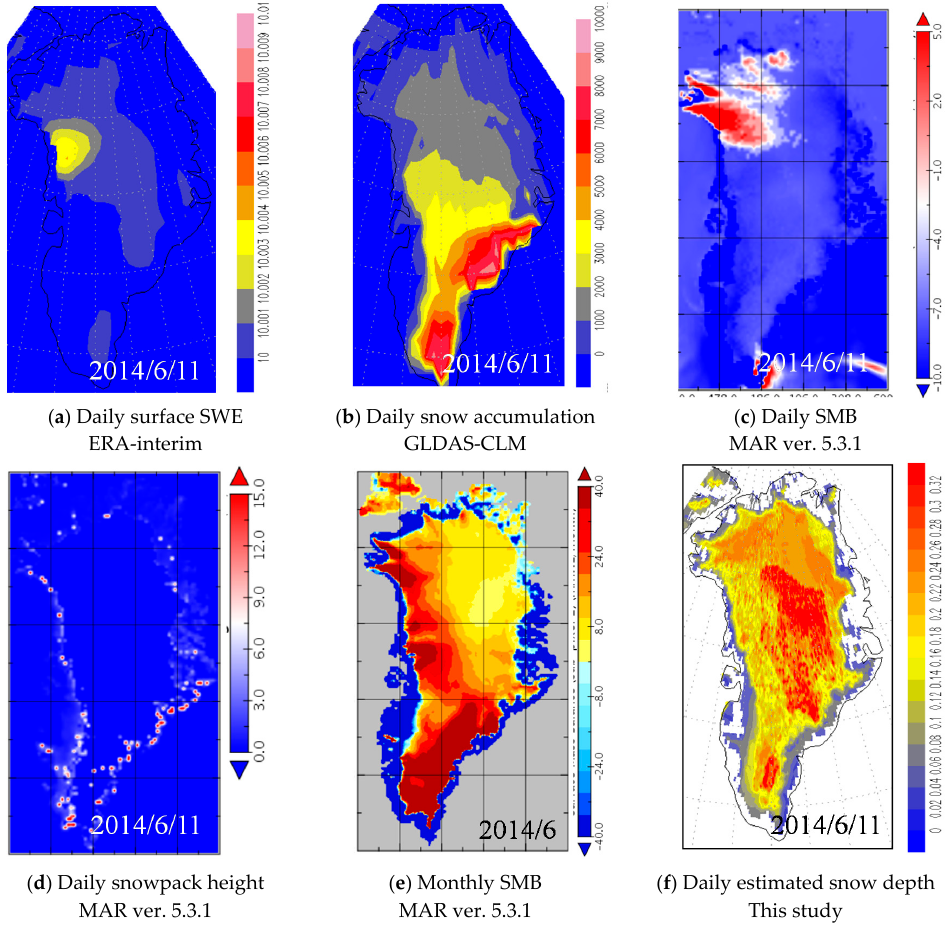
Figure 11. Daily spatial resolution on 11 June 2014 for ( a ) the daily surface snow water equivalent (SWE; m) from ERA-interim, with 0.75° spatial resolution; ( b ) the daily surface accumulation of snow (kg/m 2 ) from GLDAS-CLM, with 1° spatial resolution; ( c ) the daily surface mass balance (SMB; mm WE/day; WE = water equivalent) from MAR ver. 5.3.1 based on NCEPv1; ( d ) daily snowpack height above ice (m) from MAR ver. 5.3.1 based on NCEPv1, with 0.2° spatial resolution; ( e ) the monthly surface mass balance (SMB; mm WE/month) from MAR ver. 5.3.1, as a reference; and ( f ) daily estimated snow depth (cm) from this study, with 0.25° spatial resolution.